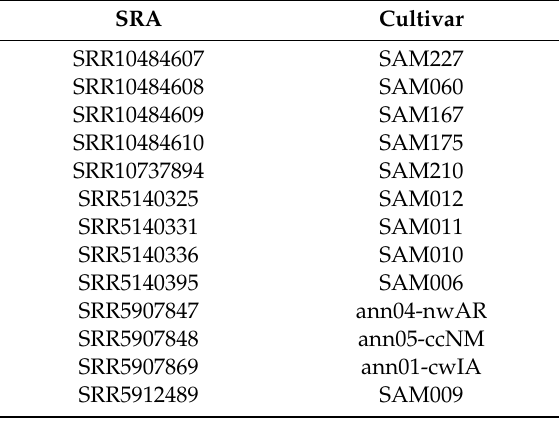
Table 2. Sequence Read Archive (SRA) accessions of genomic reads of 13 sunflower cultivars [33].